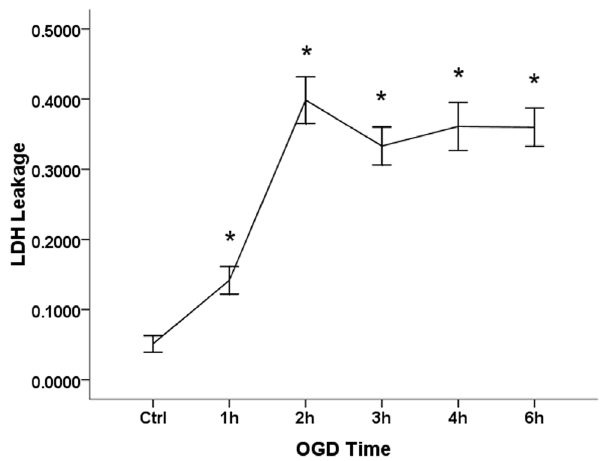
Figure 3. LDH leakage induced by mixed OGD. Mixed OGD induced a significant increase in LDH leakage after 1 h, 2 h, 3 h, 4 h and 6 h (F=220.7, P=0.001). (*) indicates a significant difference (P , 0.05) from the control group (Ctrl).